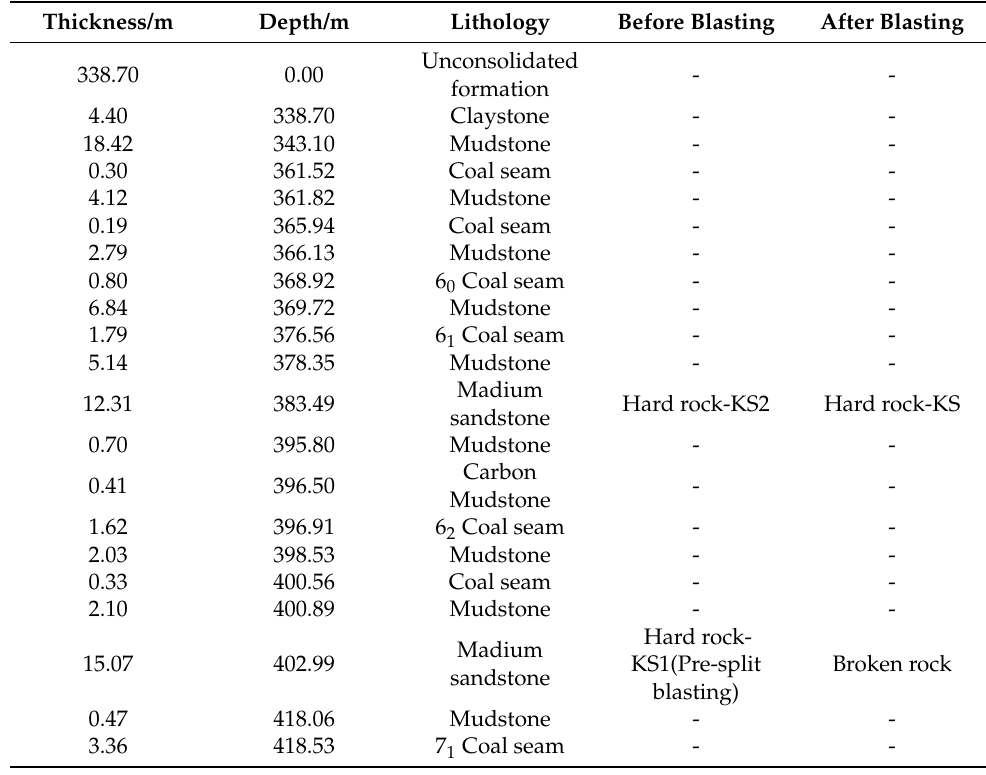
Table 4. Results of the key stratum location of borehole No.29-302 near 7 1 31 working